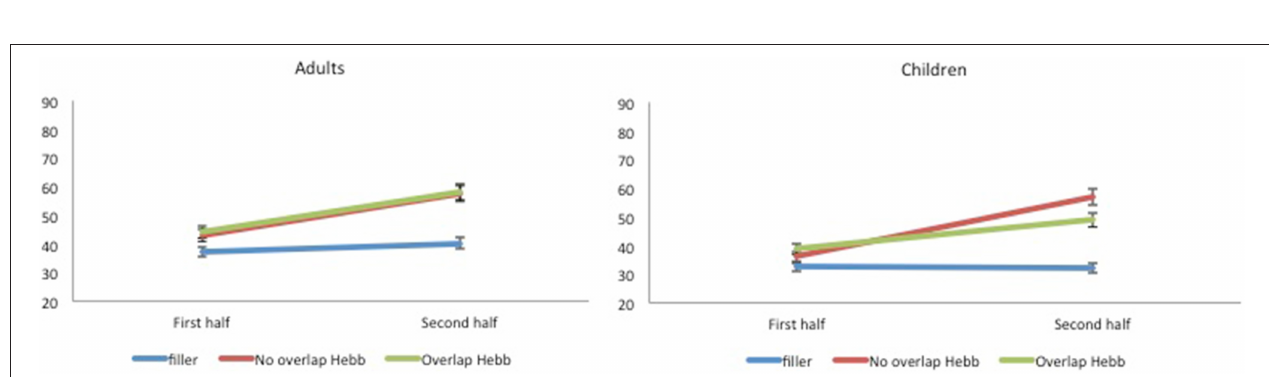
FIGURE 5 | Mean percentage of items correctly recalled (with standard errors) for Hebb and filler sequences by sequence Halves, in both children and adults, Experiment 2. Left panel: performance for adults. Right panel : performance for children.